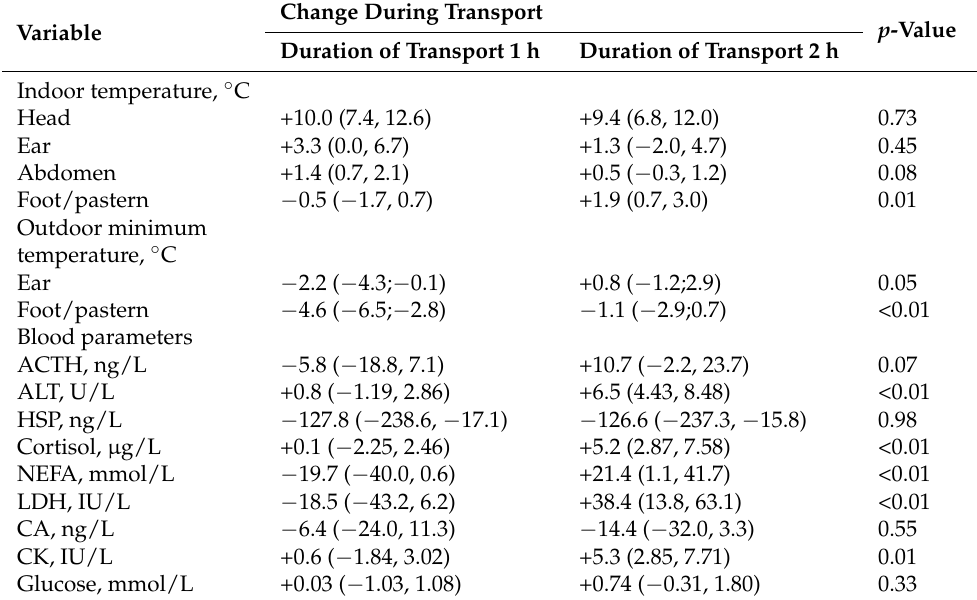
Table 2. Changes in temperatures, infrared temperature images and blood parameters during transport (values at arrival minus values at departure) of sheep (n = 2 × 10) in experiment 2. Mean changes are adjusted for departure values and are presented with 95% confidence intervals. p -values indicate the statistical significance of the treatment group effect on the adjusted